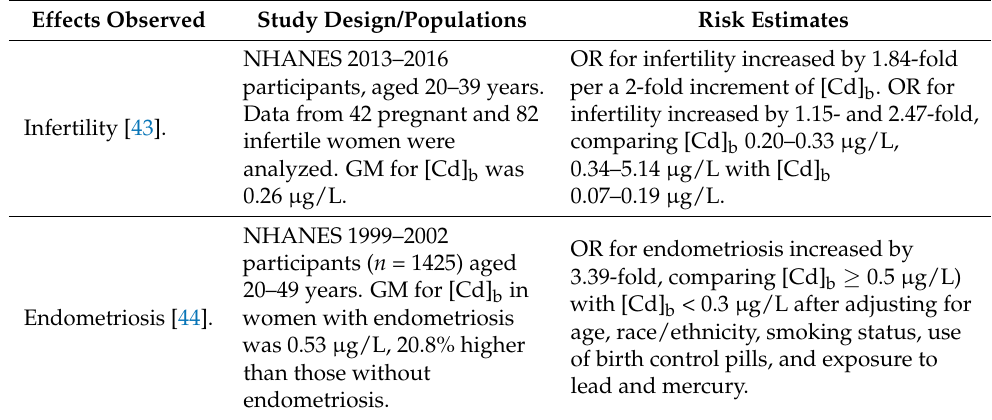
Table 2. Epidemiological evidence for the effects of cadmium on fecundity in women. Effects Observed Study